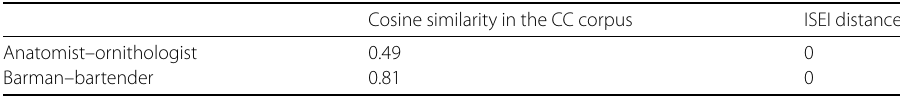
Table 2 cosine similarity and ISEI distance of occupation pairs (example)